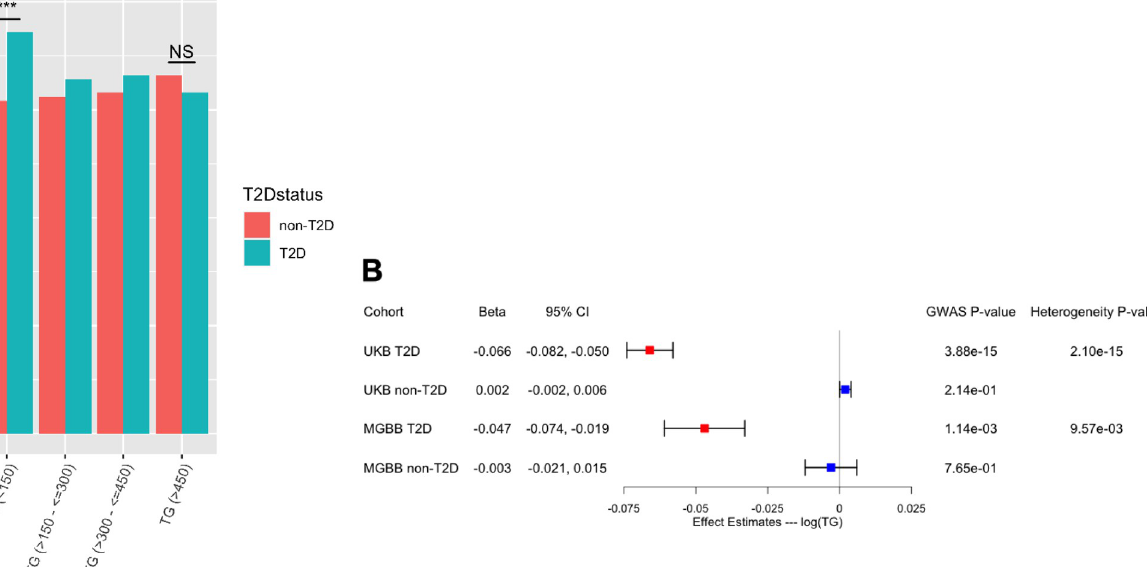
PLOS ONE | https://doi.org/10.1371/journal.pone.0275934 October 21,